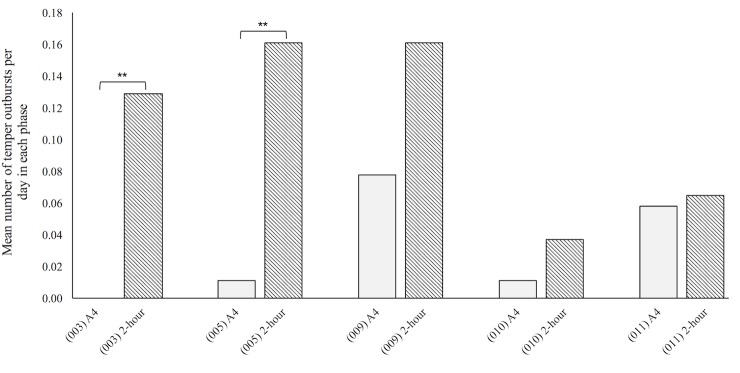
Mean number of temper outbursts per day during active phase 4 and 2-hour stimulation phase.A4, last three months of active phase; 2-hour, t-VNS worn for 2-hour in this stimulation phase. P-values of Mann-Whitney U test: 003 (p = ·000); 005 (p = ·001).